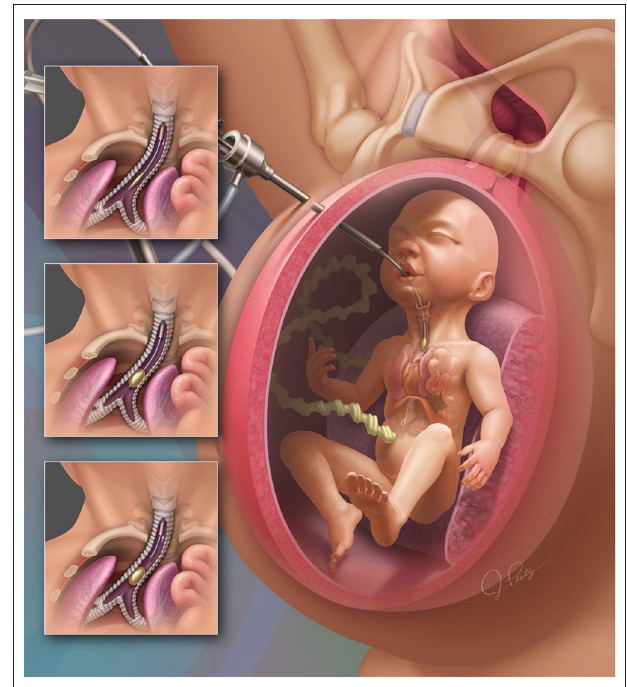
FIGURE 1 | Fetoscopic Endoluminal Tracheal Occlusion with balloon